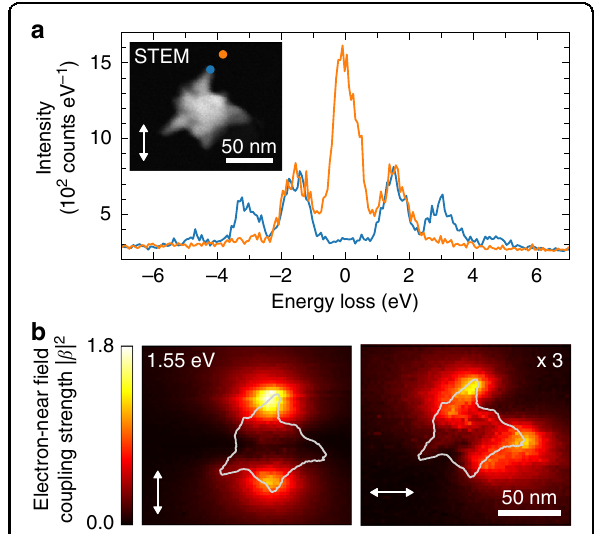
Fig. 3 PINEM measurements. a 200 keV STEM-PINEM spectra of a Au nanostar corresponding to regions of strong (blue curve) and weak (orange curve) electron-near fi eld coupling. The electron beam positions are indicated by the color-matched dots in the inset, showing an HAADF image of the nanostar. The white double arrow represents the approximate in-plane polarization of the driving fi eld. b Maps of the electron-near- fi eld coupling strength derived from the energy spectra of the transmitted electrons for two orthogonal laser polarizations, as indicated by the white double arrows. The solid lines illustrate the approximate contour of the nanostar, as inferred from the HAADF image in a . Intensities in the right-hand panel have been scaled by a factor of